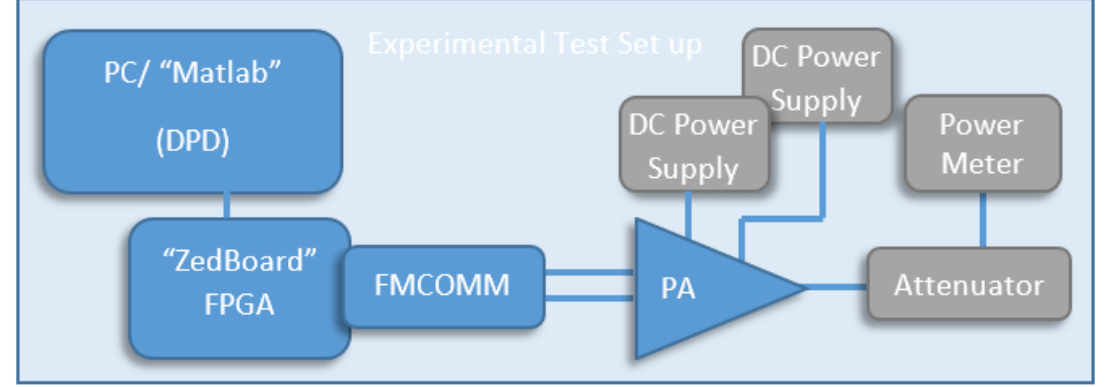
Figure 16. PA and DPD test diagram.